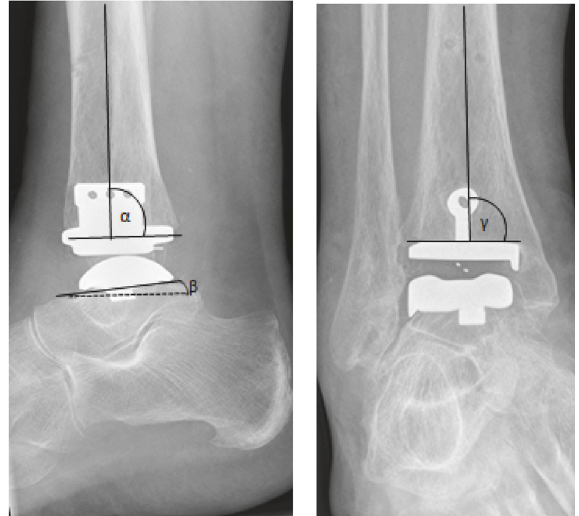
Figure 1: Radiological angles. Perfect tibial position is defined as 𝛾 angle 90 degrees and in the sagittal plane position of the tibial component with an inclination till 7 degrees ( 𝛼 = +7; according to the manufacturer of the Salto prosthesis). Perfect talar position is placement of this component parallel to the sole of the foot ( 𝛽 angle 0 degrees). An angle-difference over time of 5 degrees or more is considered significant and is classified as migration. Malposition is defined as an angulation of a component of more than 10 degrees from the perfect position as defined by Schimmel